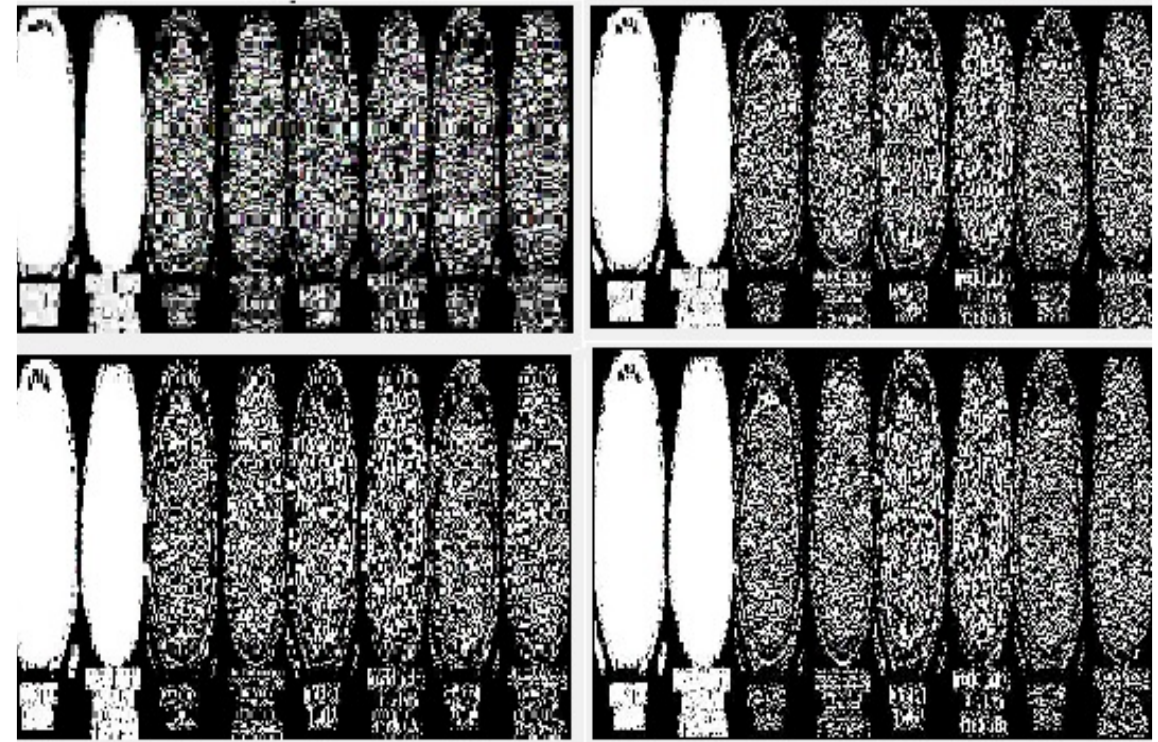
Figure 6. Compression of the transformed image.